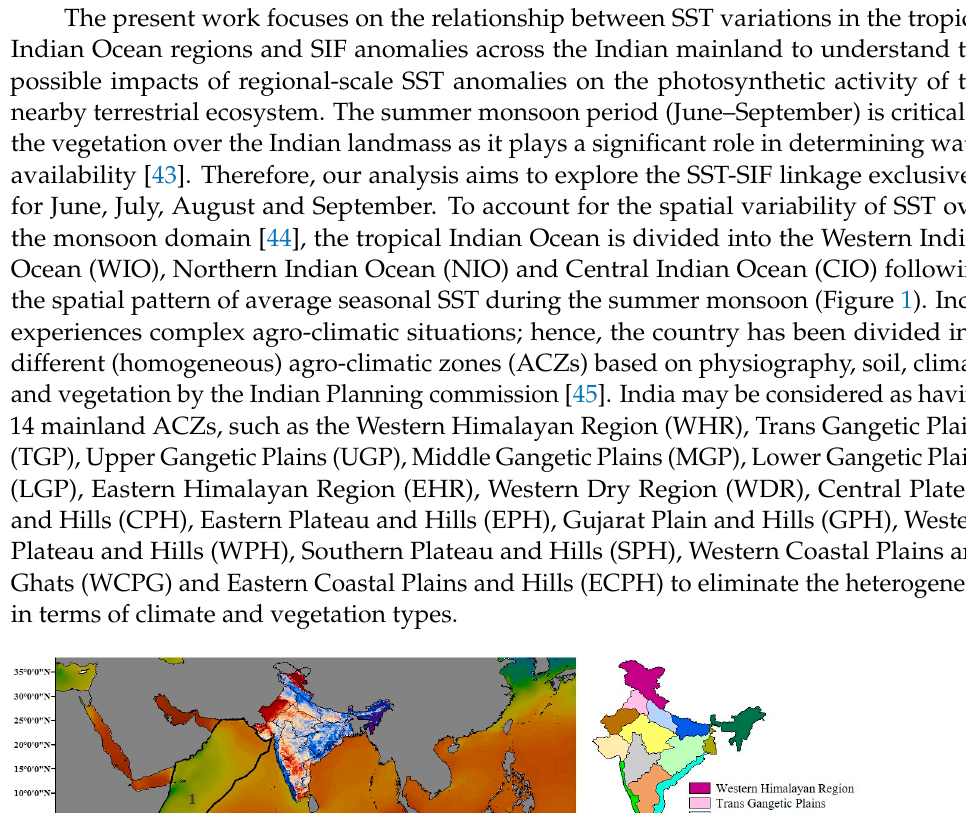
Table 1. Details of data used from 2001–2018 at monthly temporal resolution. Data